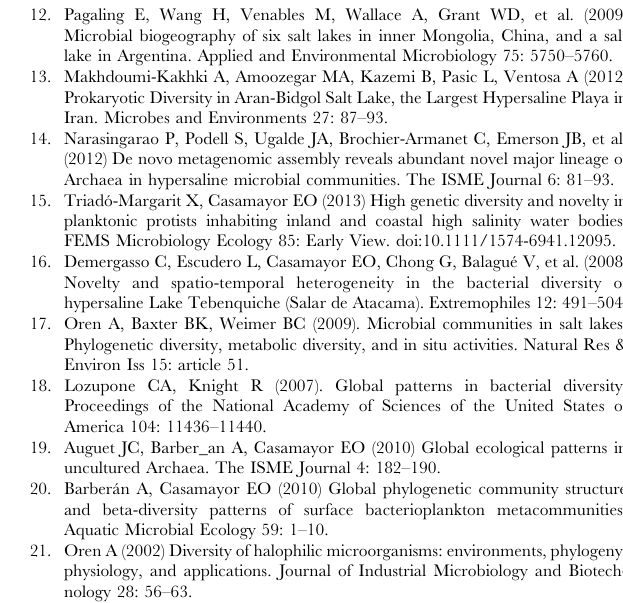
Figure S1 Estimating species richness of the investigat- ed lakes. (TIF) Figure S2 Venn diagram showing the distribution of shared OTUs across lakes in the Qaidam Basin. (TIF) Table S1 shows Cumulative fit per species as fraction of variance of species. Table S2 shows Taxa assignments at class level